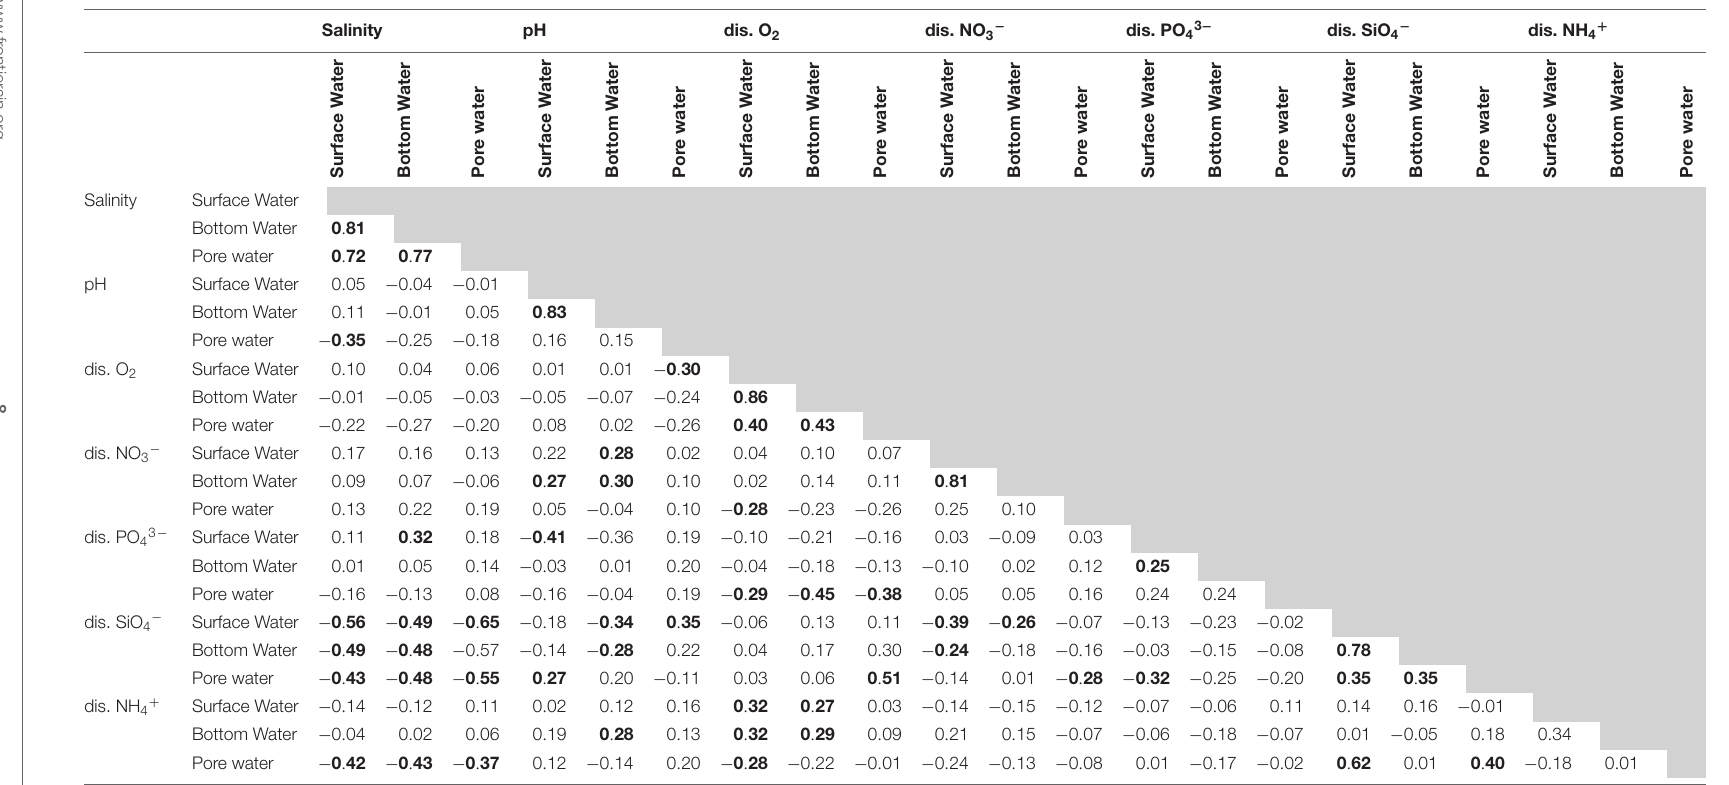
Values from surface and bottom water fractions have been calculated by considering a sample size of n = 72, while values from pore water fractions have been calculated by using, n = 54. Significant values (p ≤ 0.05) have been